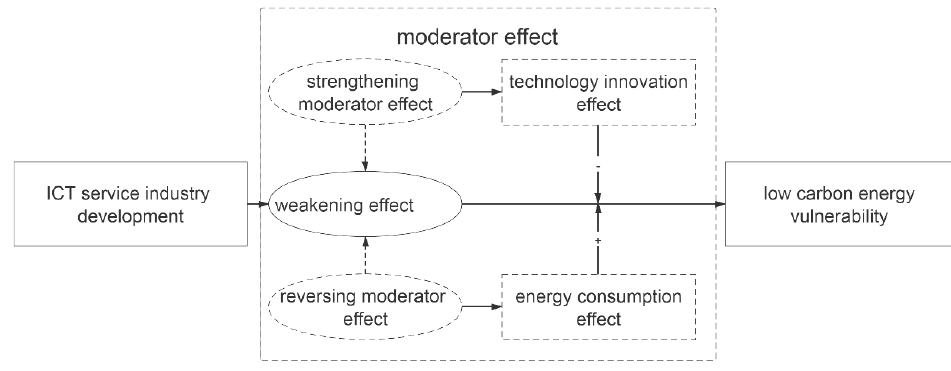
Figure 1. The theoretical framework.